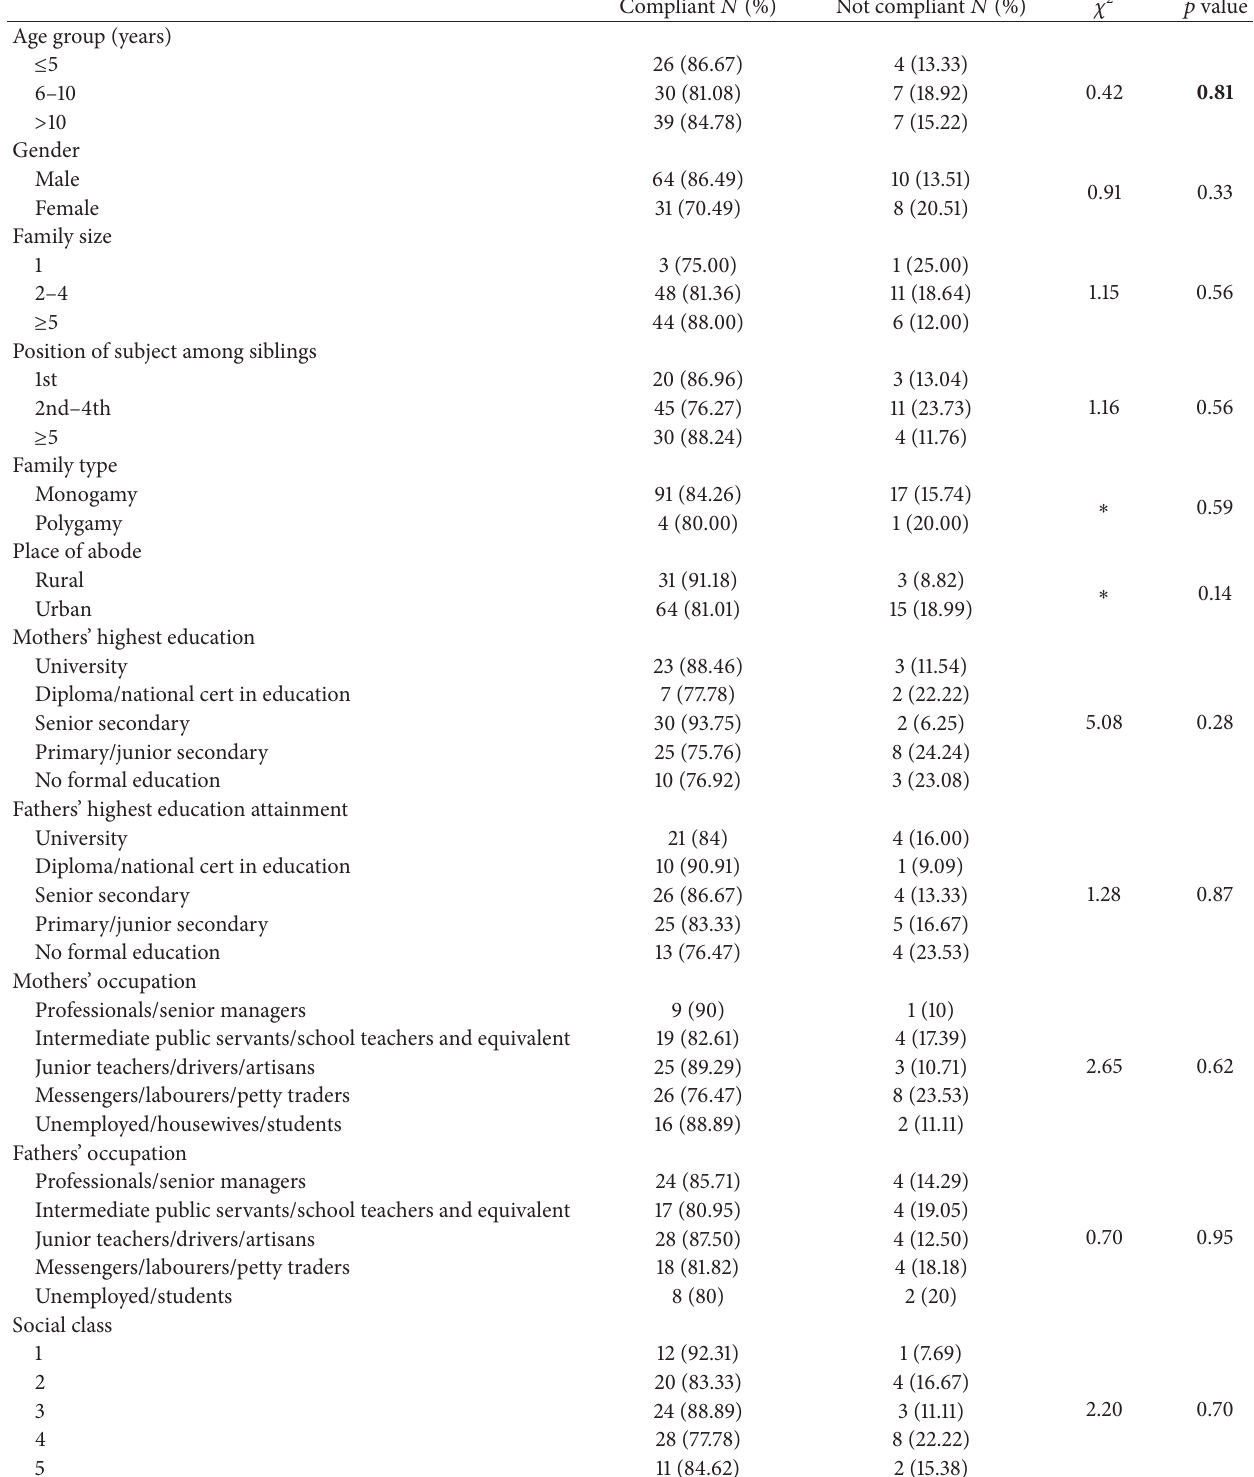
Table 4: The association between noncompliance to medication and some sociodemographic